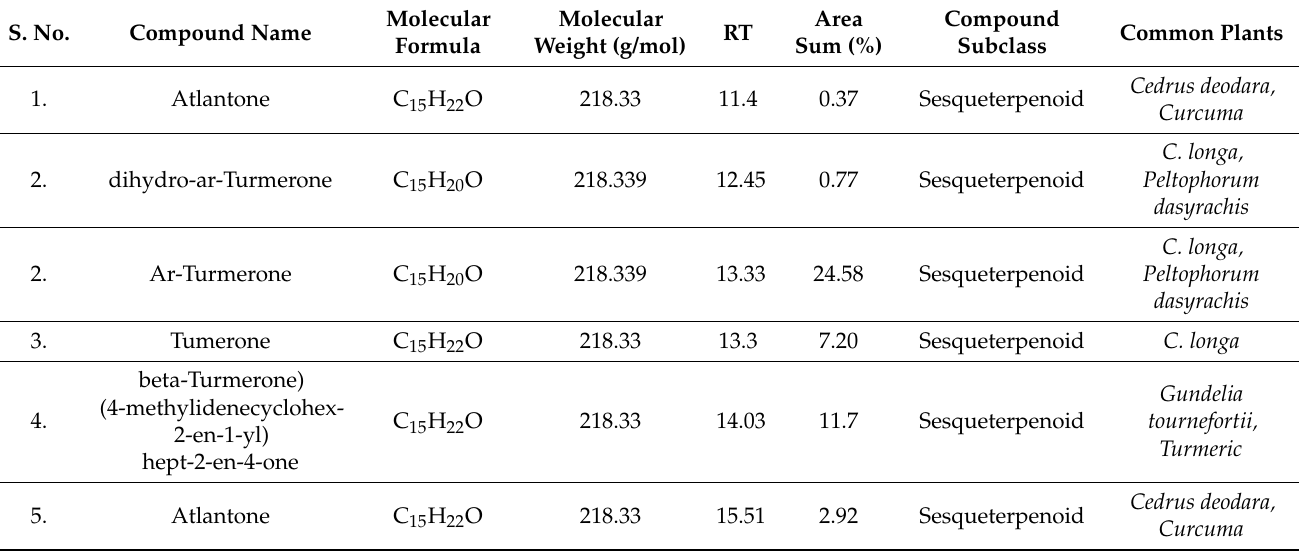
Table 2. Important bioactive compounds in HECl as analyzed by GC-MS/MS.